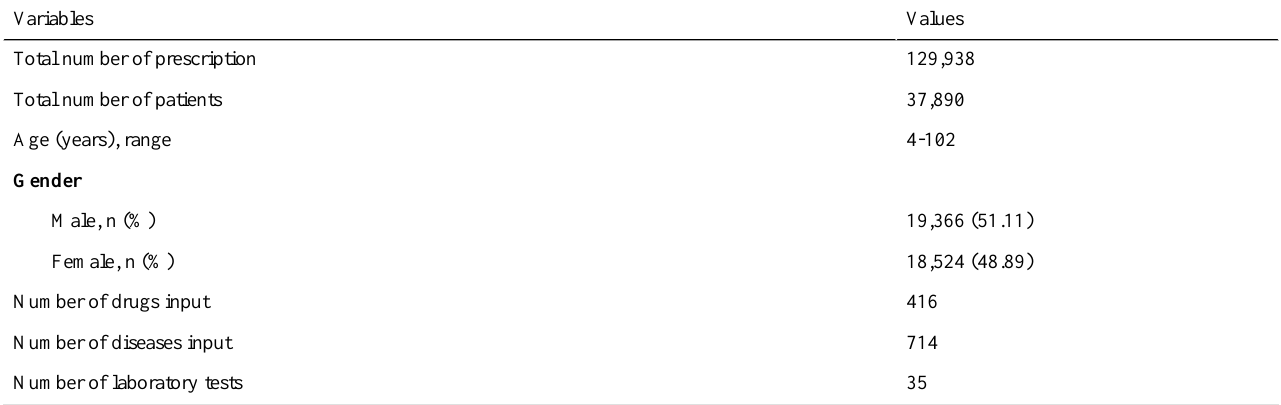
Table 1. Characteristics of patients and clinical